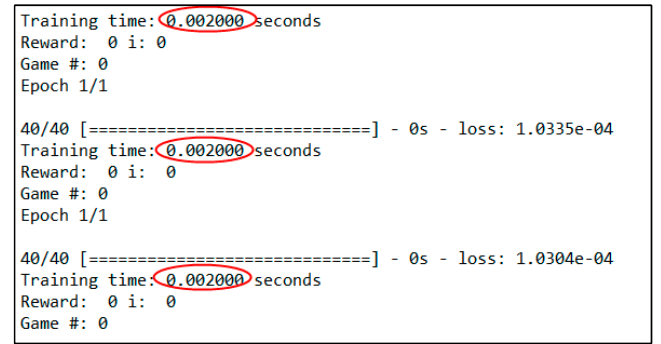
Figure 11. Training Time using a Graphical Processing Unit (GPU).